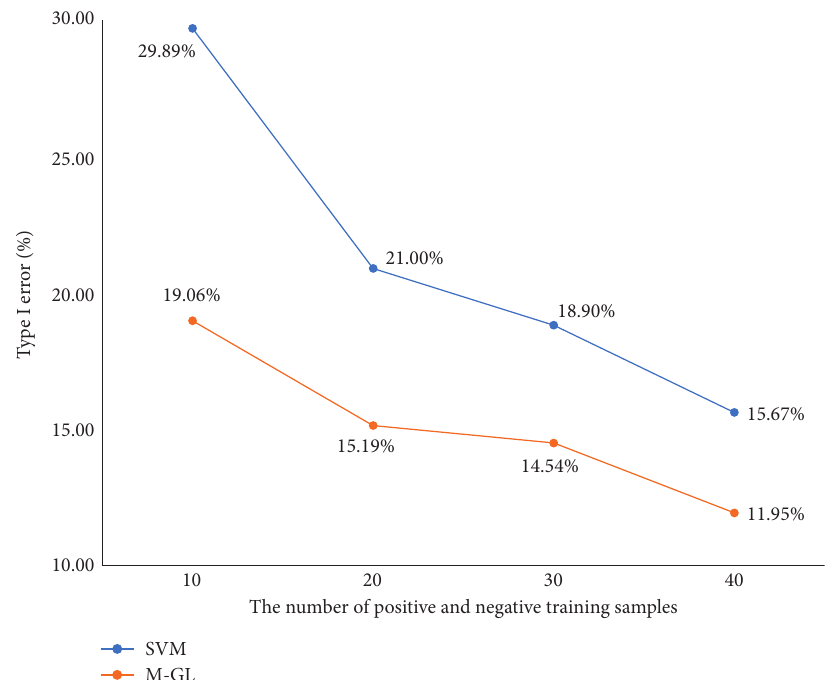
Figure 5: Variations of Type I error with the increased number of labeled samples for M-GL.